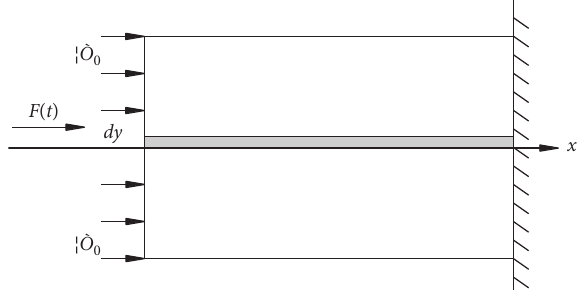
Figure 1: Stress wave propagation model under ground